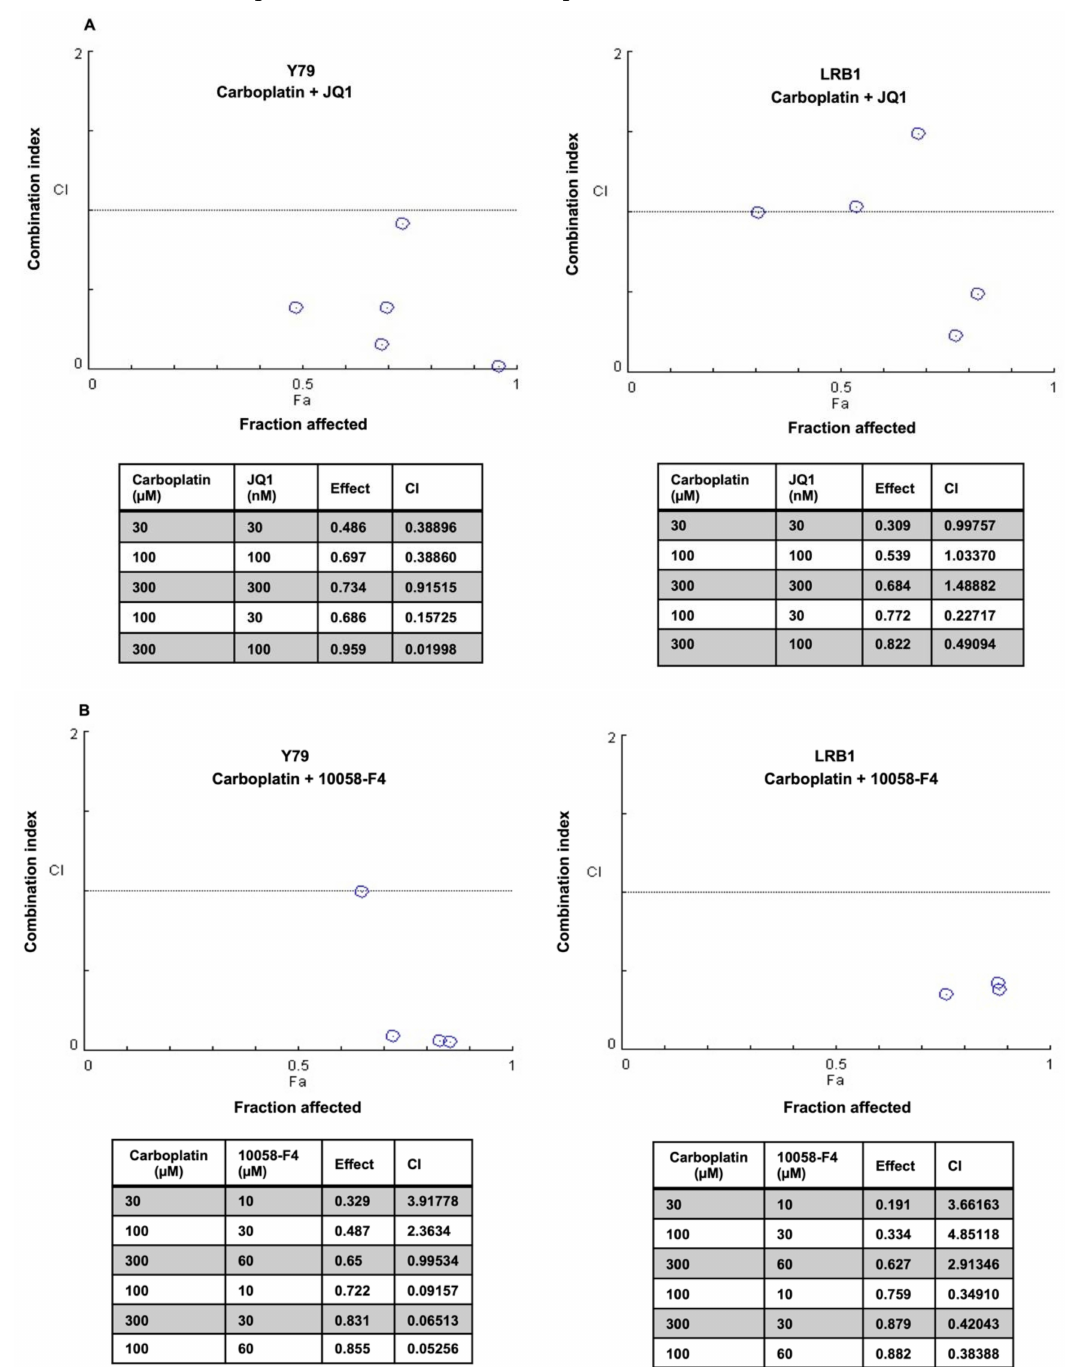
Figure 8. Combination effects of carboplatin and small molecule inhibitors of MYCN on RB cell viability. Y79 and LRB1 cells were treated with carboplatin, JQ1 and 10058-F4 either alone or in combination. Combination Indices (CI) were